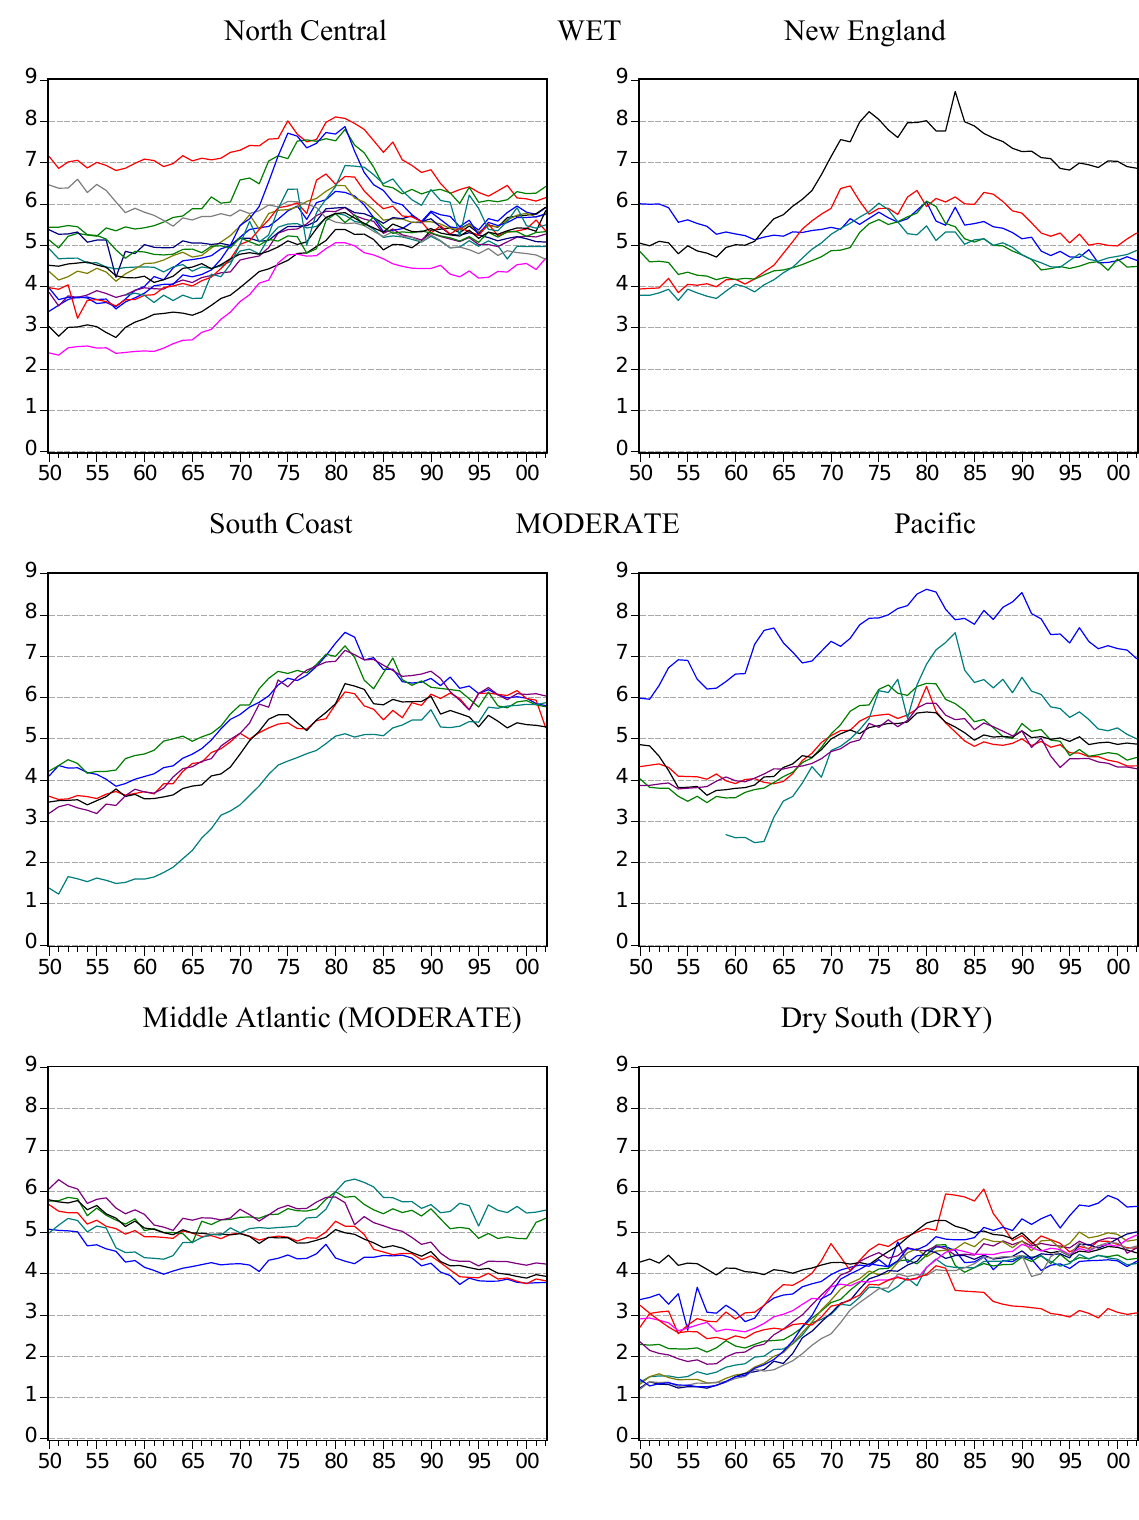
Figure 2. Apparent consumption of beer in liters of ethanol per capita aged 15+ by state in groups over the years from 1950 to 2002. North Central WET New